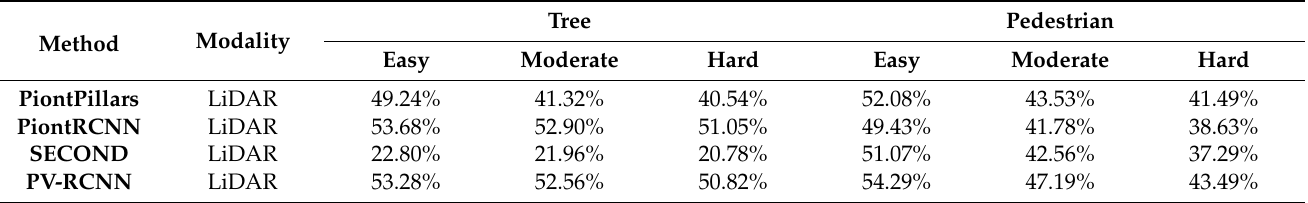
Table 4. Comparison of detection results of four network